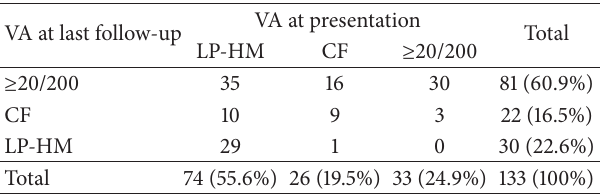
Table 7: The distribution of initial and final visual acuity in eyes with vitreous hemorrhage caused by accidental trauma.